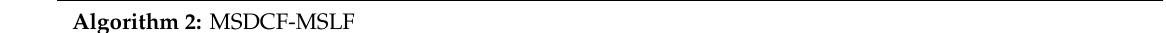
Algorithm 2: MSDCF-MSLF